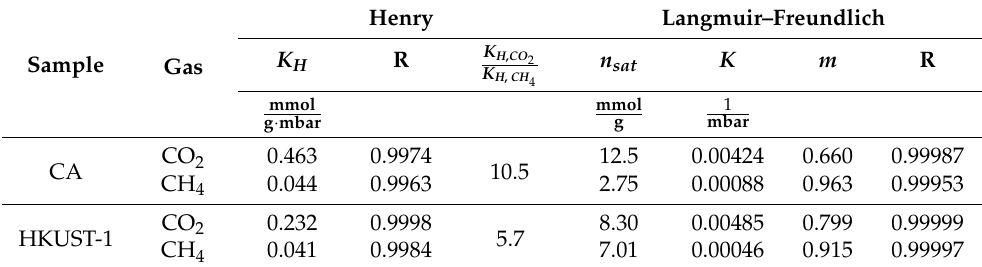
Table 3. Parameters derived from Henry and Langmuir–Freundlich fits.